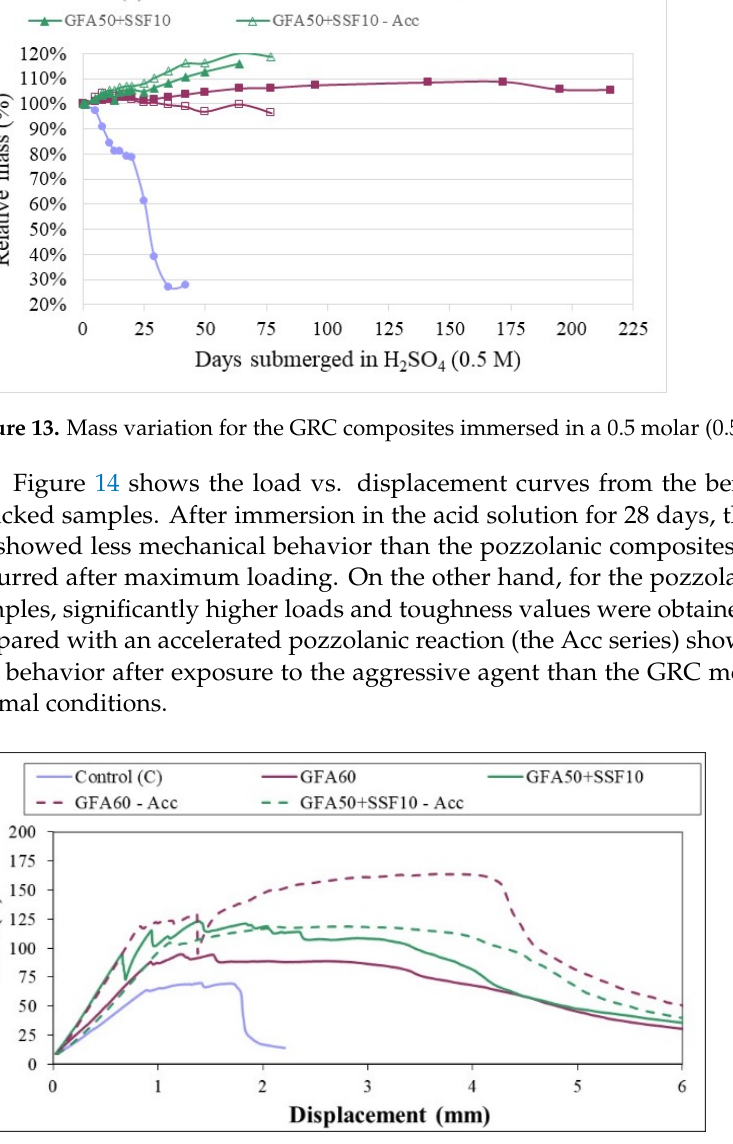
Figure 14. Load–displacement curves (load rate 0.03 ± 0.003 mm/s) for the GRC composites im- mersed for 28 days in a 0.5 M H 2 SO 4 solution.